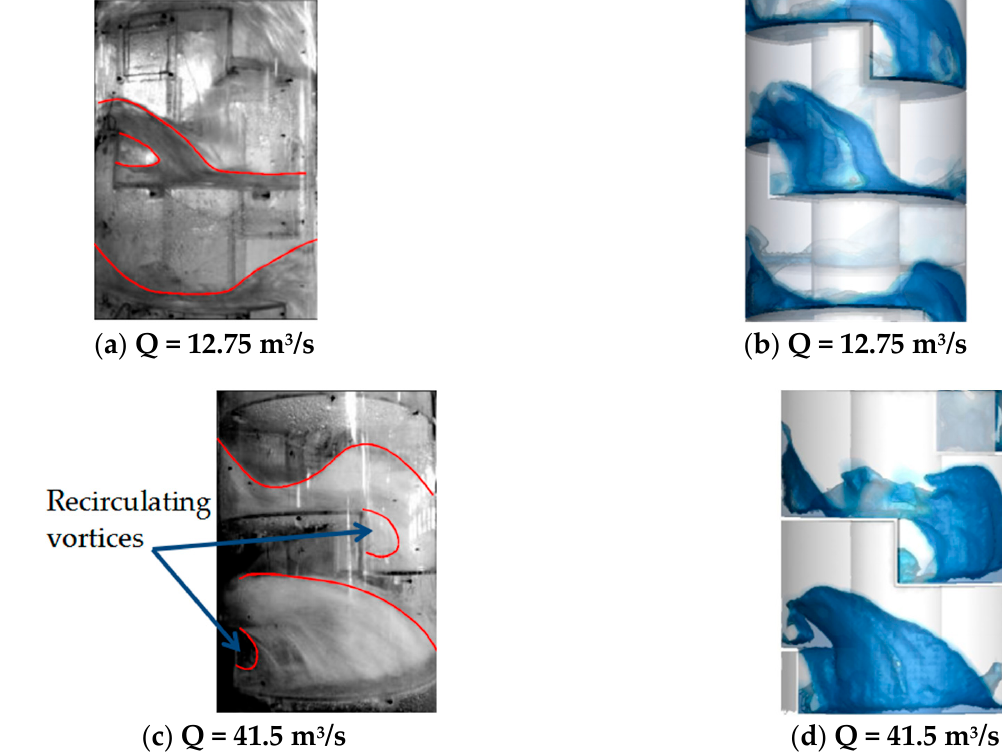
Figure 3. Comparison of experimental and calculated flow pattern: ( a ) and ( c ) flow pattern in experiment; ( b ) and ( d ) flow pattern in simulation.